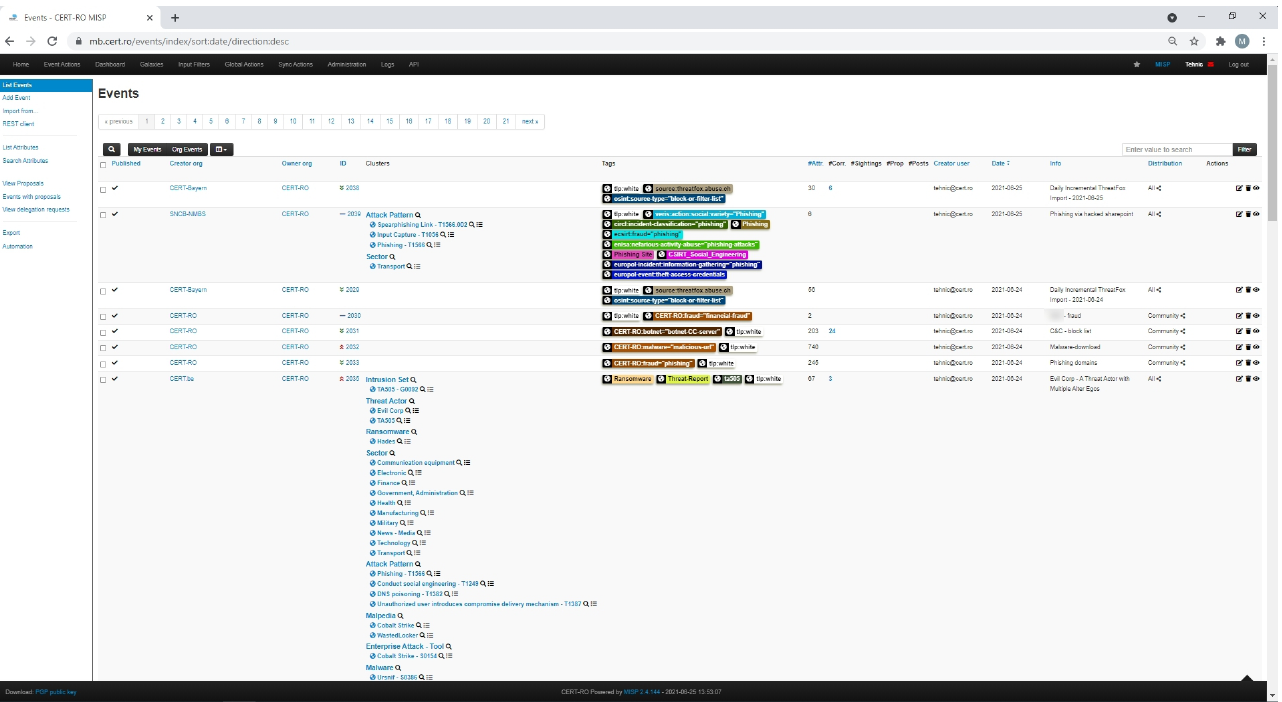
Figure 2. Examples of TLP:WHITE events that can be shared from CERT-RO’s MISP instance to the GEIGER cloud. CERT-RO’s MISP data tagged with ‘TLP:WHITE’ is made available to GEIGER in a feed that can be imported in the GEIGER backend component in the cloud. TLP stands for Traffic Light Protocol; a protocol created to promote the sharing of information. TLP is a set of designations used to ensure that sensitive information is shared with the appropriate audience. It employs four colours to indicate expected sharing boundaries to be applied by the recipient(s). The four colours are red (named recipients only), amber (limited distribution), green (community-wide distribution), and white (unlimited